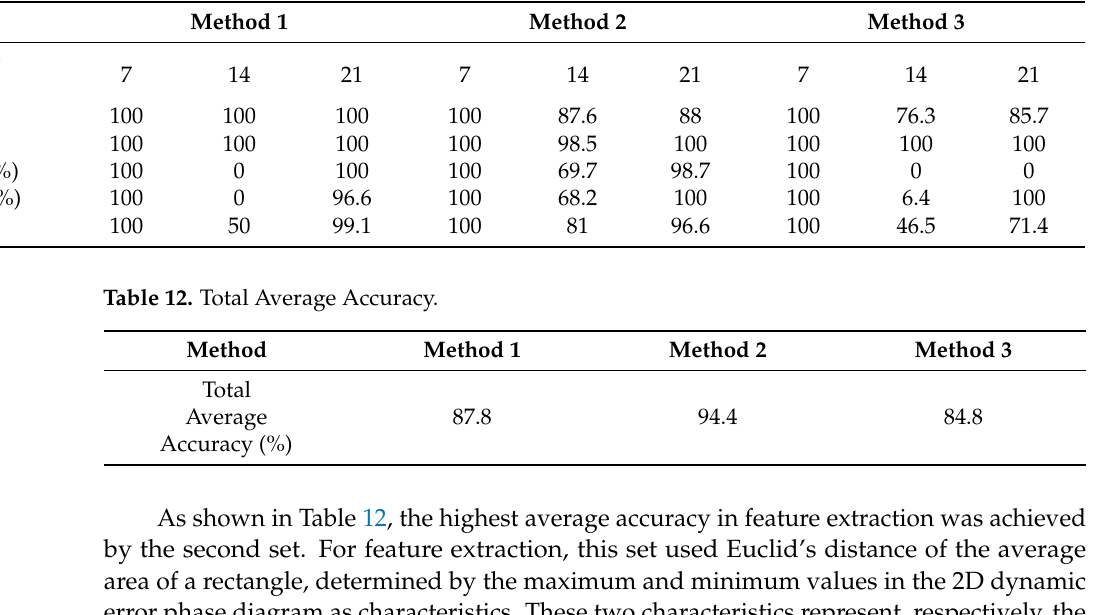
Table 11. Accuracy When HP = 3.